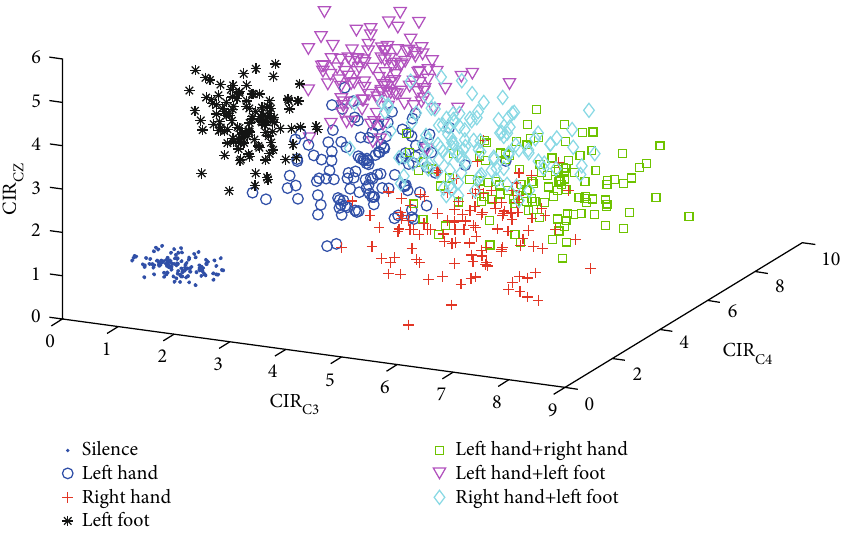
Figure 5: CIR distribution of seven mental tasks.